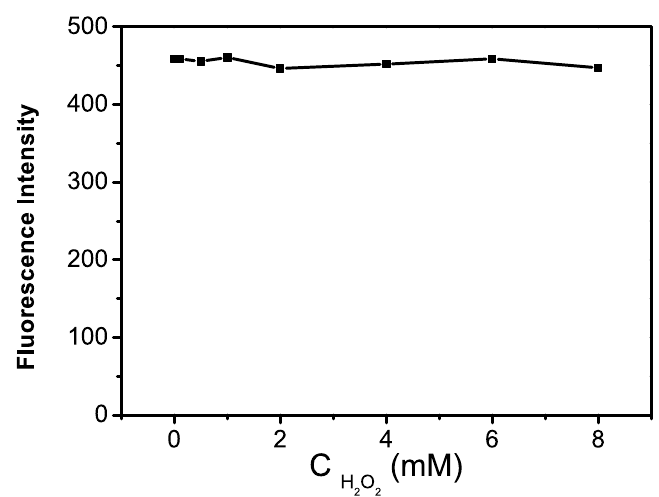
Figure 2. The effect of concentration levels of H 2 O 2 on the PL intensity of GQDs.